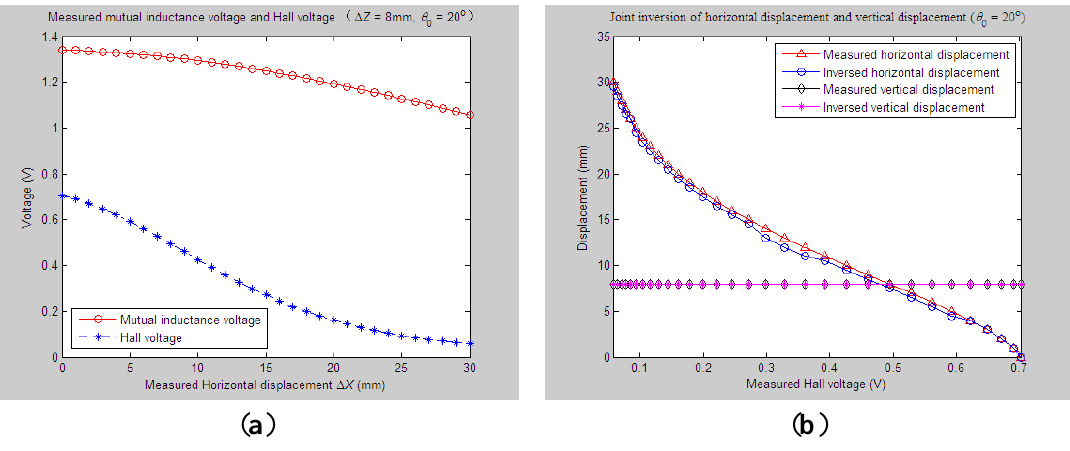
Figure 10. Horizontal and vertical displacement joint inversion results when measured Δ X are changed, while measured Δ Z remain stable ( θ 0 = 20°, Δ Z = 8 mm). ( a ) Measured mutual inductance voltage and Hall voltage; ( b ) inversed horizontal and vertical